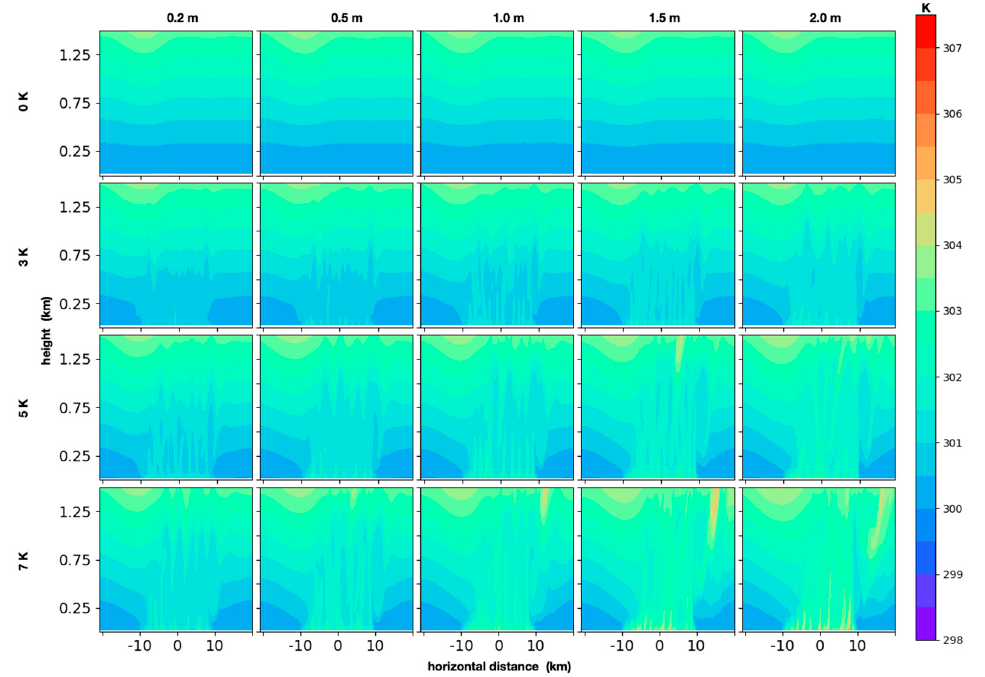
Figure 2. Same as Figure 1, except showing potential temperature (K).